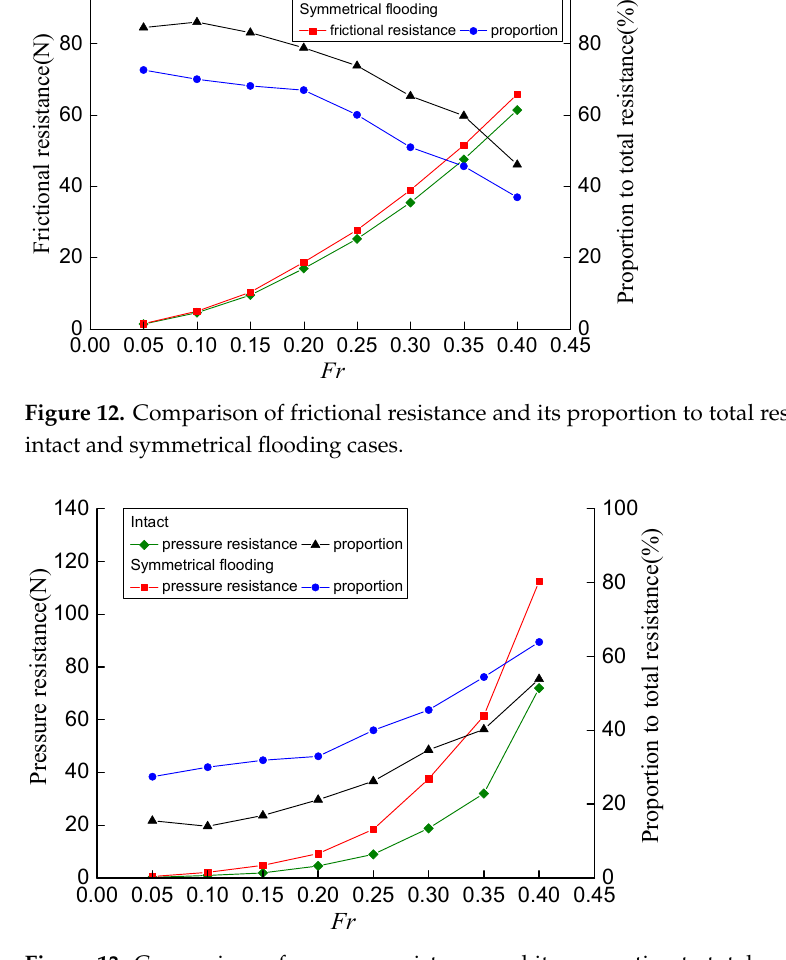
Figure 13. Comparison of pressure resistance and its proportion to total resistance for the ship in intact and symmetrical flooding cases.